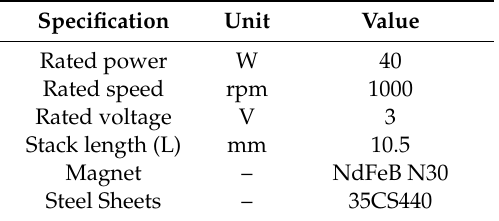
Table 1. The specification of the as-designed 6 / 5